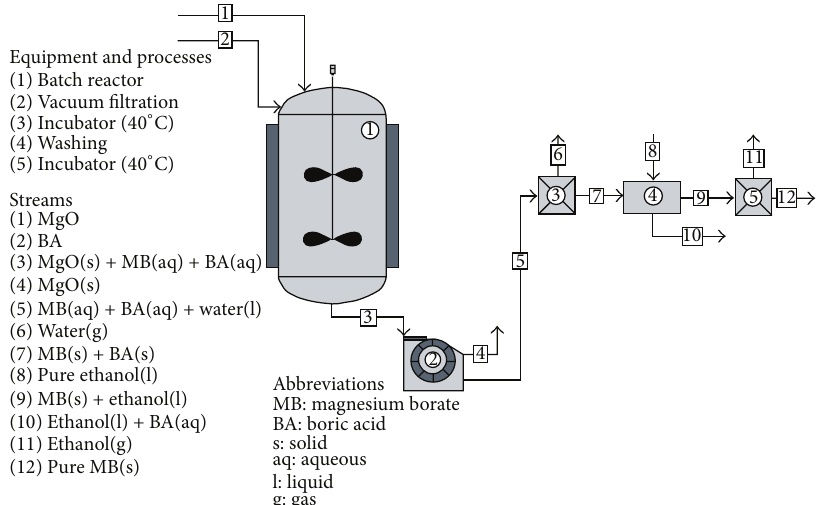
Figure 1: Synthesis procedure of magnesium